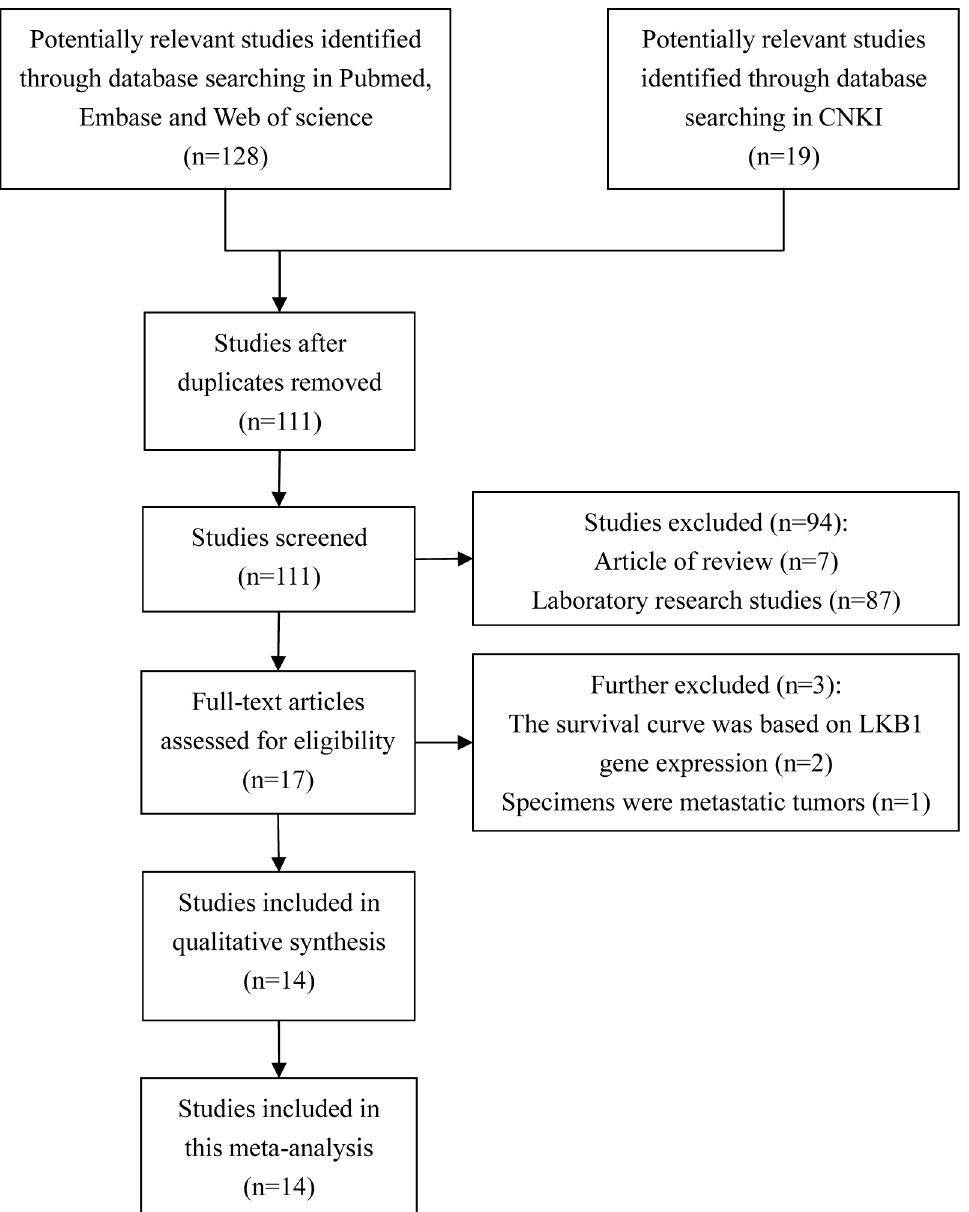
Fig 1. Flow diagram of the selection of eligible